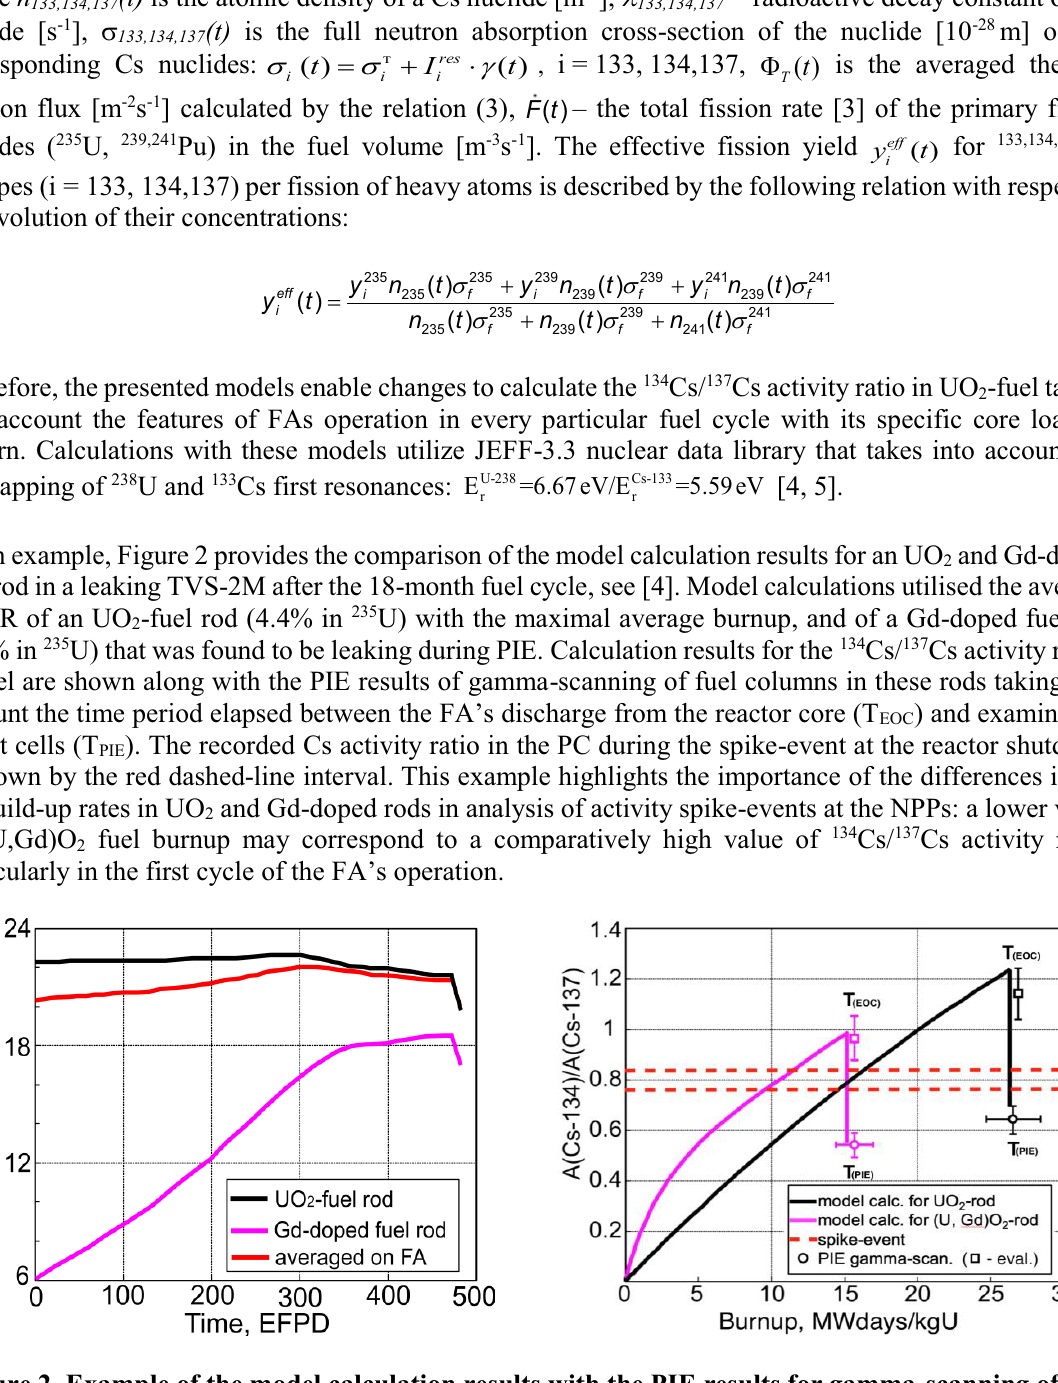
Figure 2. Example of the model calculation results with the PIE results for gamma-scanning of the fuel rods in TVS-2M analysed in the previous work